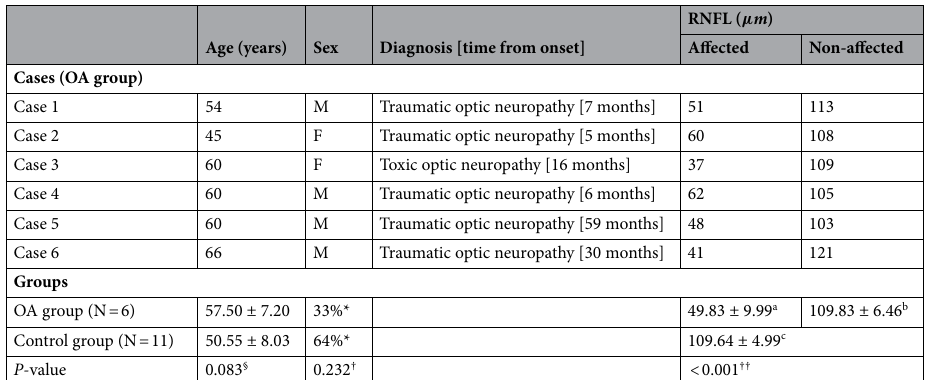
Table 1. Demographics and clinical characteristics of patients with optic atrophy (OA group) and control subjects (control group). Continuous variables in each group are presented as the mean ± standard deviation. N number of subjects, OA optic atrophy, RNFL total retinal nerve fiber layer thickness, F female, M male. *Female ratio percentage. † Chi-square test. †† Mann–Whitney U test (a vs. b, a vs. c). § Mann–Whitney U test. a Mean of RNFL thickness in affected eyes. b Mean of RNFL thickness in non-affected eyes. c Mean of averaged RNFL thickness in both eyes.